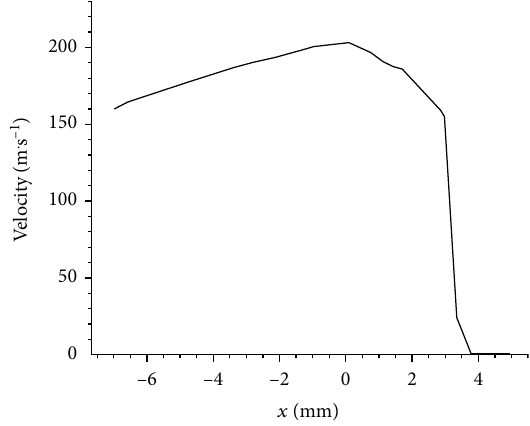
Figure 3: Velocity distribution on the symmetry